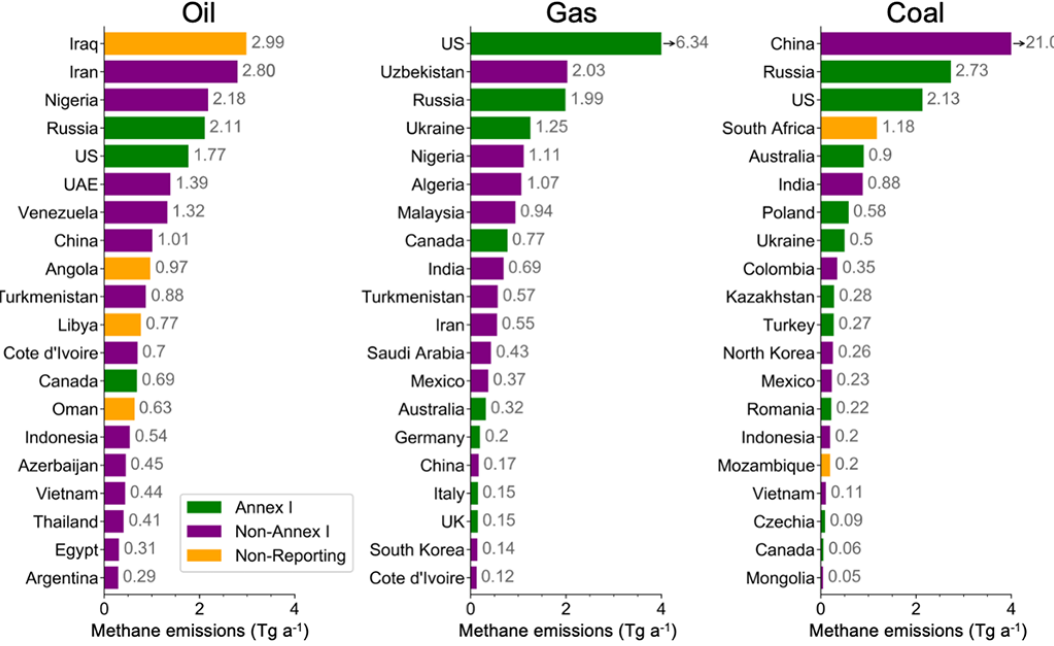
Figure 2. Oil, gas, and coal methane emissions by country for 2019 from GFEI v2. Emissions are shown for the top 20 emitting countries. Arrows next to the top bars (highest emitting countries) indicate that emissions are not to scale. US – United States; UAE – United Arab Emirates; UK – United